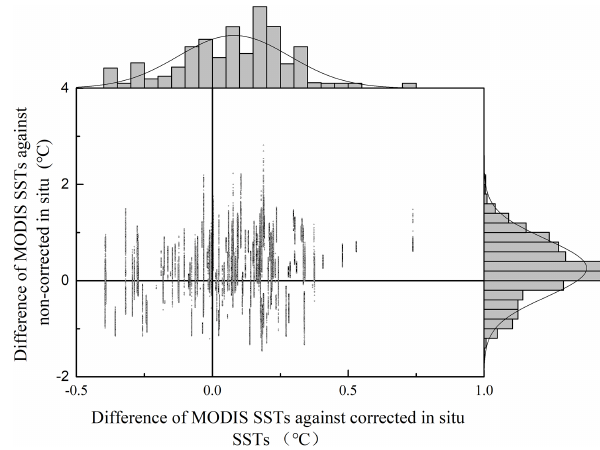
Figure 13. Marginal histogram of the difference between in situ data before and after correction and the corresponding MODIS SST data. (The margins of the scatterplot are a histogram of the vari- ables, indicating the distribution of data in either direction.)